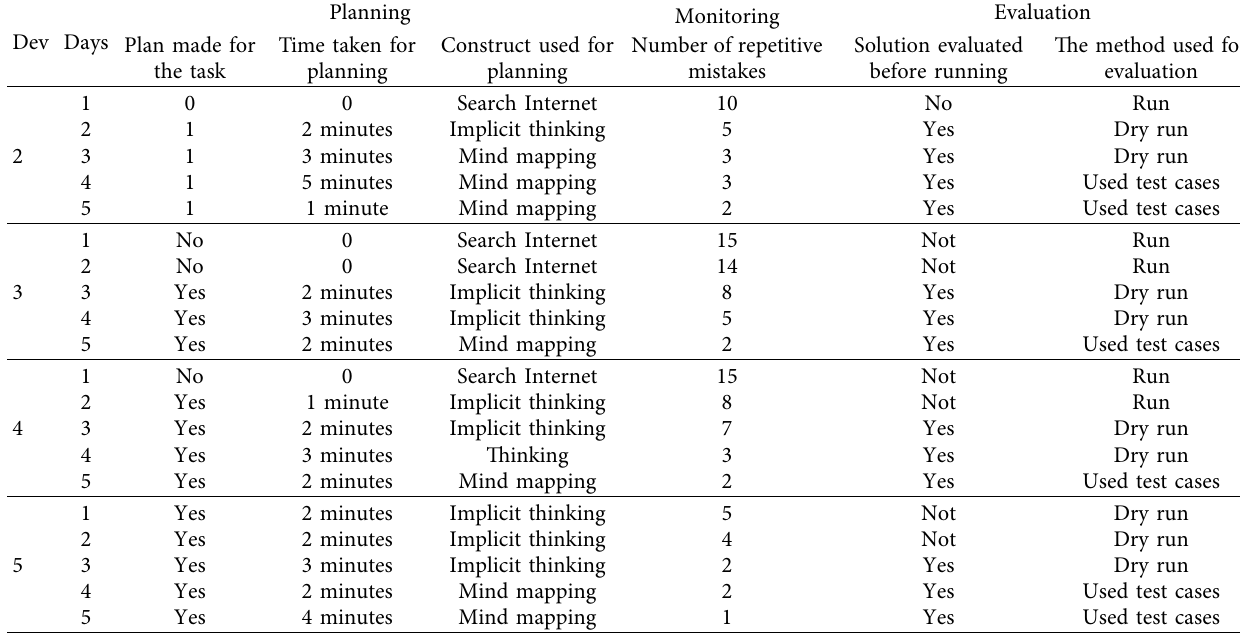
Table 5: All developers planning, monitoring, and evaluation data.